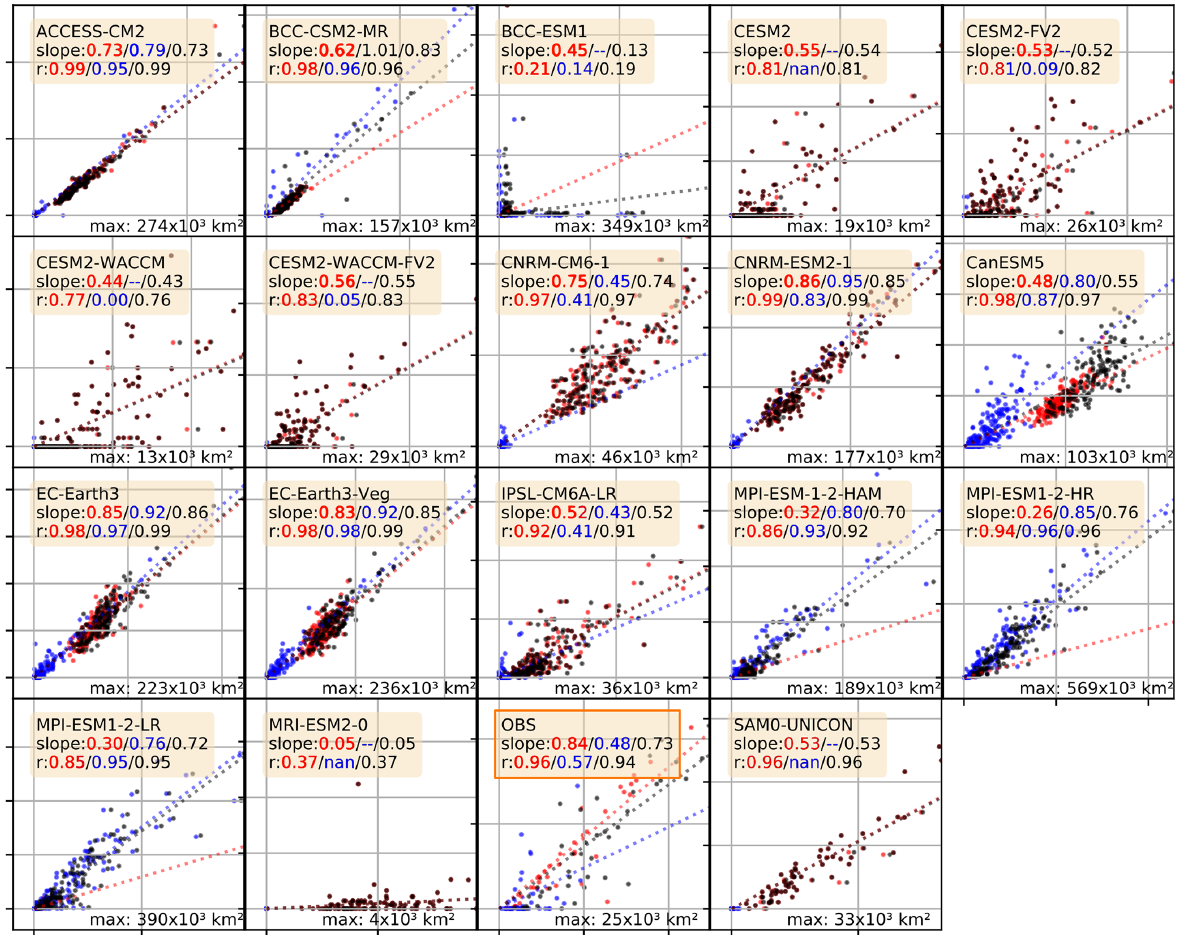
Figure A1. Correlation plots for the polynya areas computed from daily ( x ) vs. monthly ( y ) sea ice concentrations as presented in Table 2. Each dot represents the averaged polynya area of one year; red are the coastal polynyas, blue the OWPs and black the sum of both. Where applicable (e.g. polynyas present, p value < 0.05) the legend includes the slopes of the correlation in the order coastal/open-water/combined polynyas. Because the area of polynyas varies by more than 1 order of magnitude, we normalised the axes of each plot by the highest numerical value for each model and give its value in the lower right corner of each